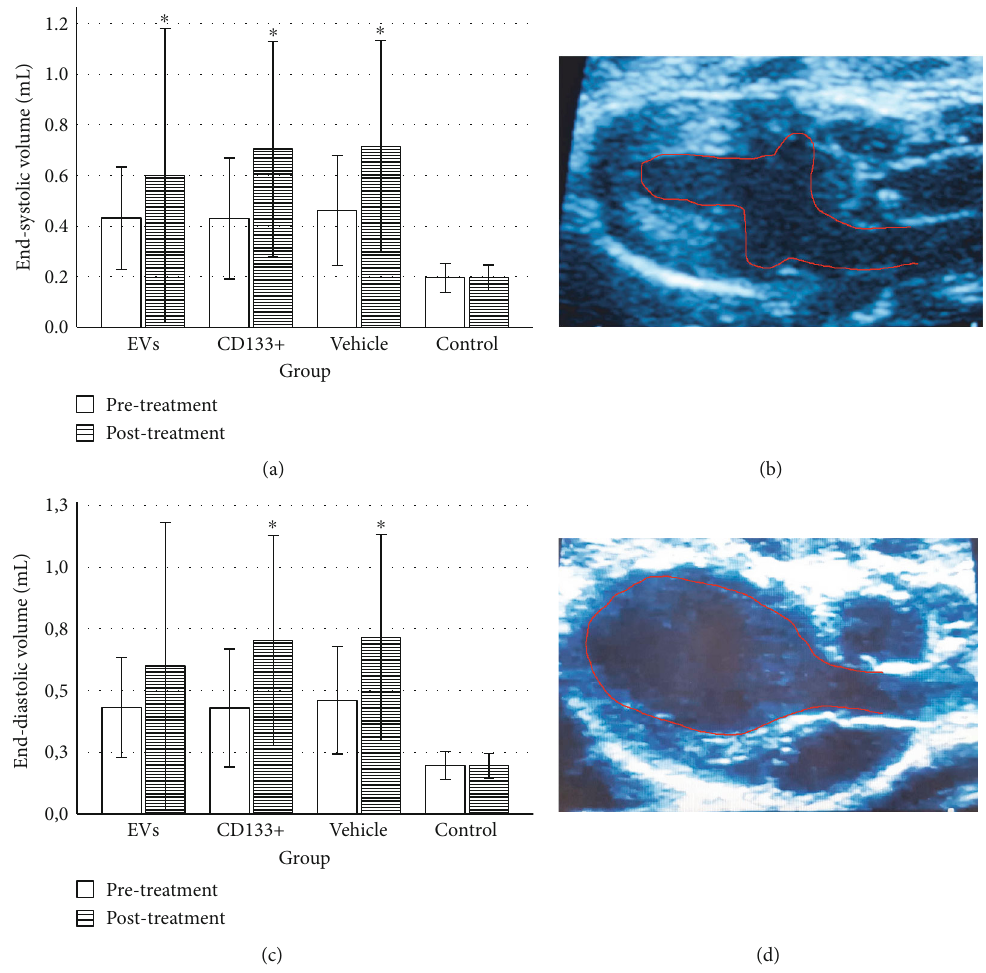
Figure 3: Echocardiographic evaluation of end-systolic and end-diastolic volume. Comparison of left ventricular end-systolic volume (a) and left ventricular end-diastolic volume (c) within each group pre- and posttreatment. Representative two-dimensional echocardiographic images of end-systolic volume (b) and end-diastolic volume (d) in a healthy animal of the control group. EVs: transplanted with expanded CD133 + cell-derived EVs; CD133 + : transplanted with expanded CD133 + cells; vehicle: treated with PBS; control: healthy animals. ∗ Signi fi cant di ff erence between pre- and posttreatment moments of each group ( P > 0 : 05 ). Data are represented as median, minimum and maximum values, and SEM bars ( n = 6 to 8 per group).